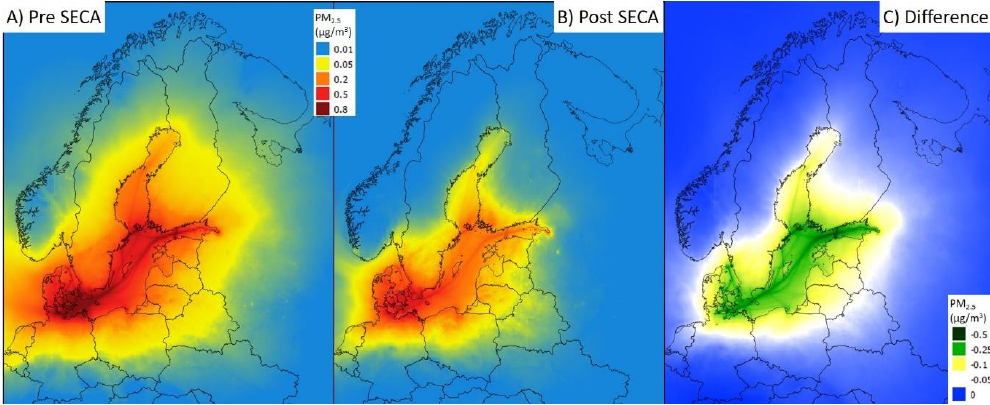
Figure 1. Estimated contribution of shipping emissions in the Baltic Sea to PM 2.5 . ( A ) in 2014 (before the SECA regulations of marine fuel sulfur). ( B ) in 2016 (after the SECA regulations of marine fuel sulfur). ( C ) Difference between 2014 and 2016. In all cases, the estimated contributions to PM 2.5 were modelled using the same meteorology (average for 2014–2016). Int. J. Environ. Res. Public Health 2019 , 16 , x FOR PEER REVIEW